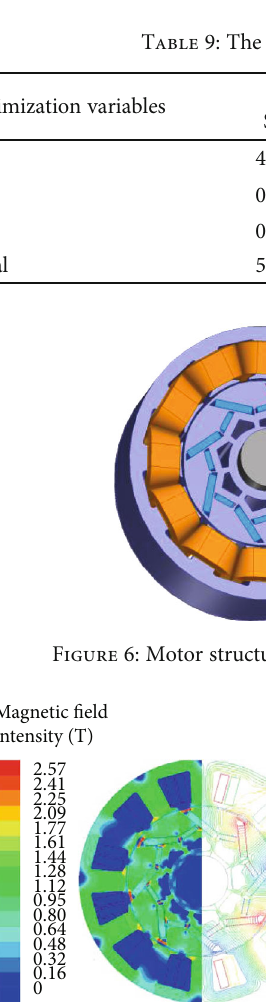
Figure 7: Static magnetic fi eld analysis.